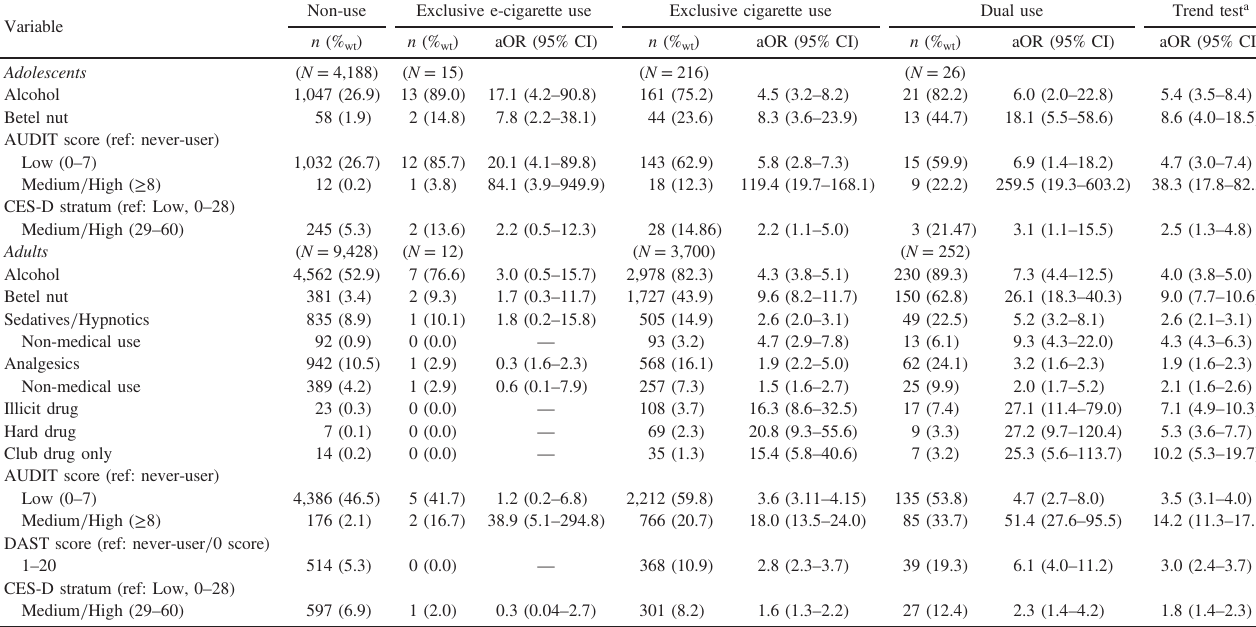
Table 4. Multivariable multinomial logistic regression of tobacco usage groups, using people with non-use as the reference group, on other substance use and depression in the 2014 National Survey of Substance Use in Taiwan